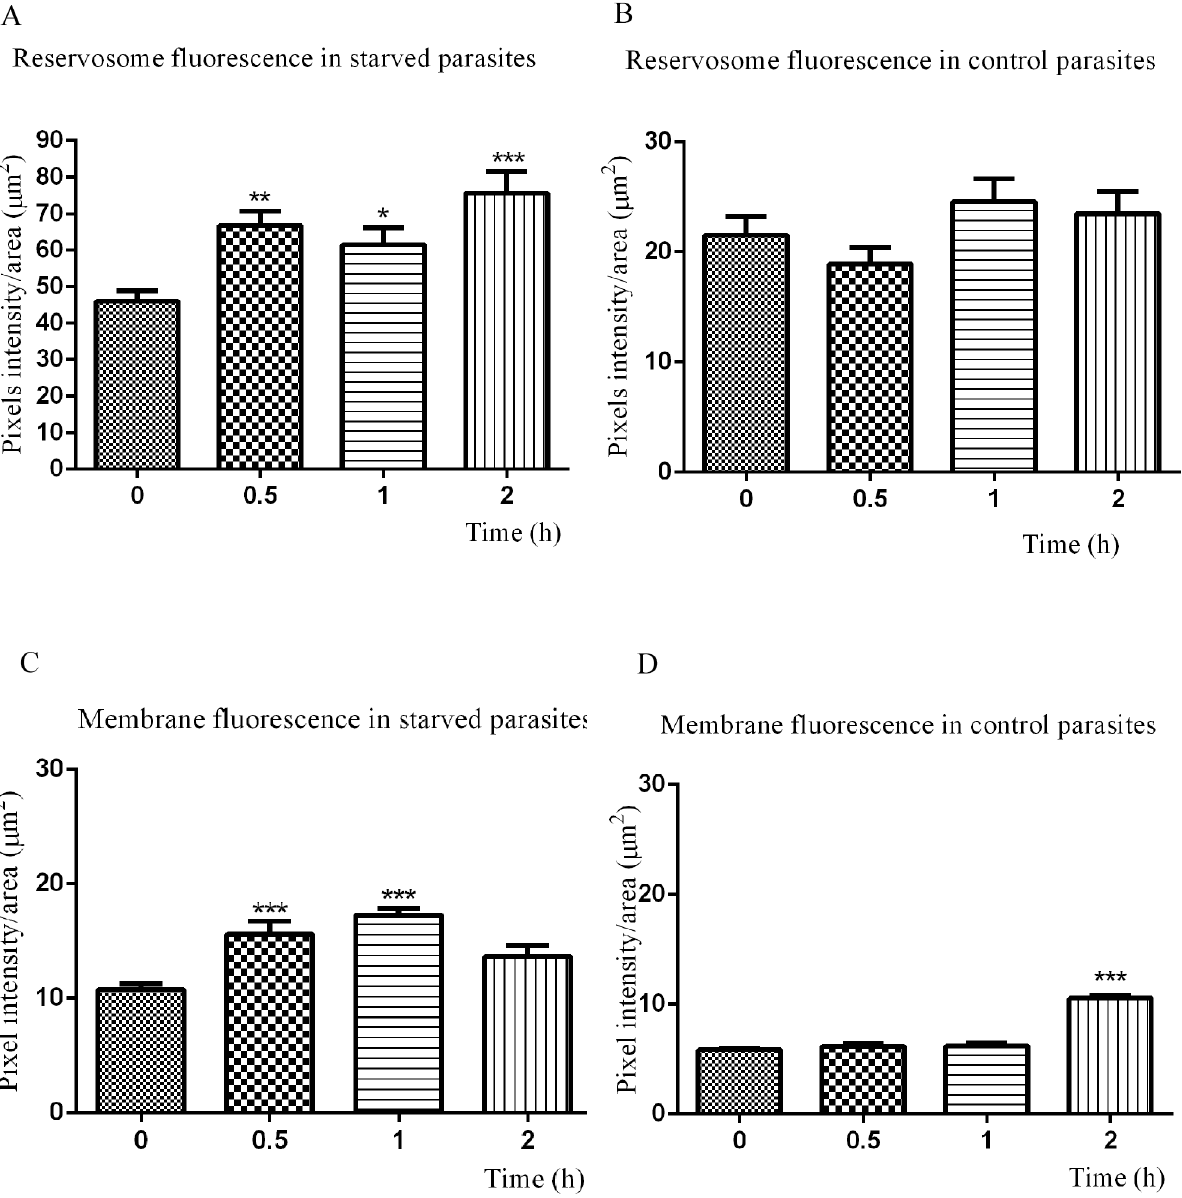
Fig 3. Quantification of NBD-cholesterol distribution in epimastigotes according to time. Starved parasites (A) uptake more LDL-NBD-cholesterol than controls (B), comparing fluorescence intensity in reservosomes/vesicles at time zero (immediately after washing off the tracer). The fluorescence intensity in reservosomes varies with time in starved parasites, but not significantly in control reservosomes, except after 2h. Starved parasites quickly redistribute the exogenous NBD-chol to their membranes (C) after 30 min, while in control cells (D) the NBD-chol rate increases only after 2 h of traffic. The results are expressed as the mean ( ± SD) and analysed with the one-way ANOVA test in comparison to time zero ( * / ** / *** significantly different, P <